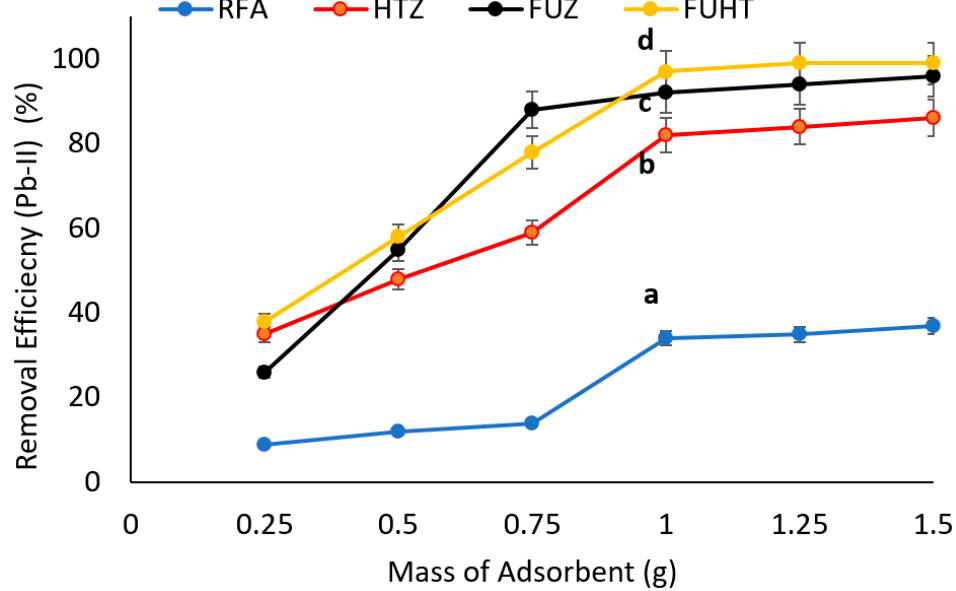
Figure 6. Effect of dose of adsorbents (RFA and Na-zeolites) on removal efficiency of Pb (II) at 100 mg/L metal ion concentration, pH ≈ 8, and 30 min contact time at 25 °C. Notes: a,b,c,d shows significant ( p < 0.05) differences among different zeolite samples.